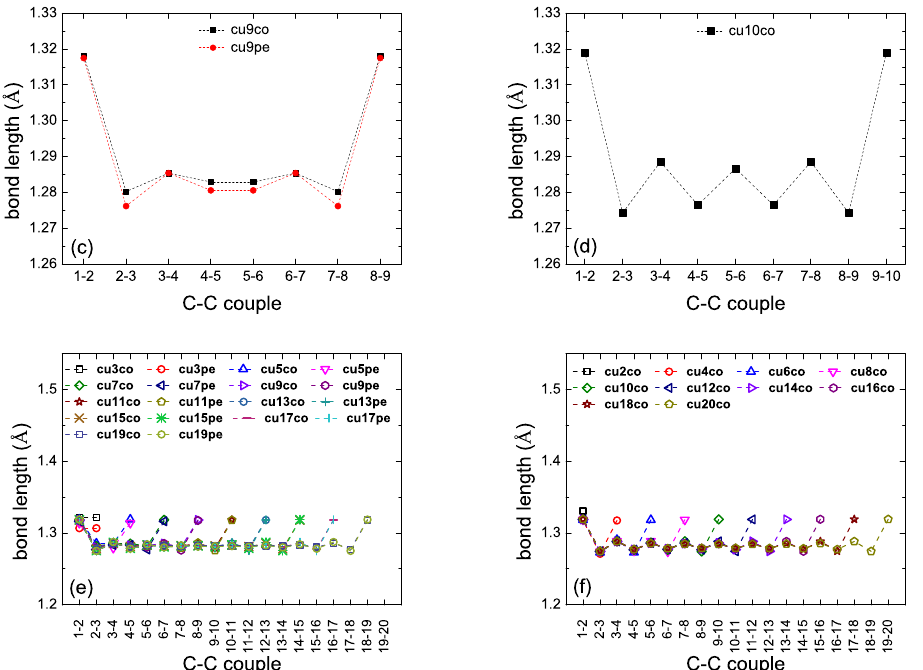
Figure 2. Bond lengths of cumulenic molecules. B3LYP/6-31G* level of theory, without any constraint on the position of atoms. ( a ) N = 7, ( b ) N = 8, ( c ) N = 9, ( d ) N = 10, ( e ) N odd, ( f ) N even.